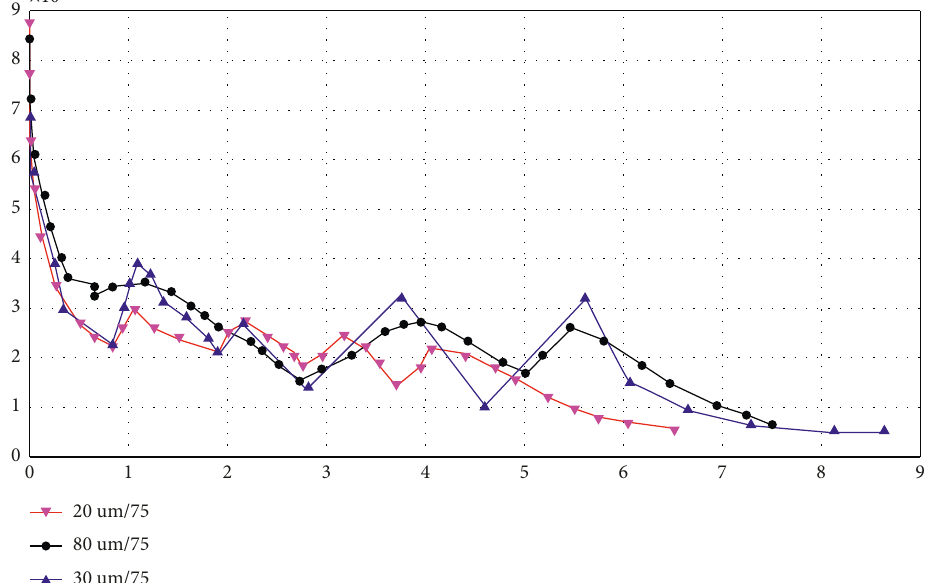
Figure 12: Three distinct hexagonal nanoparticles were used to create a scattering curve